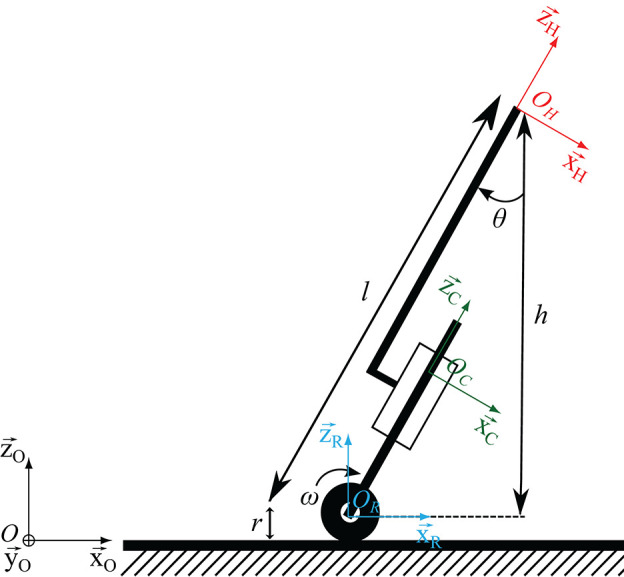
Robotic cane model, ℜ0 inertial frame, ℜR the wheel frame, ℜℜC chassis frame, ℜH handle frame.